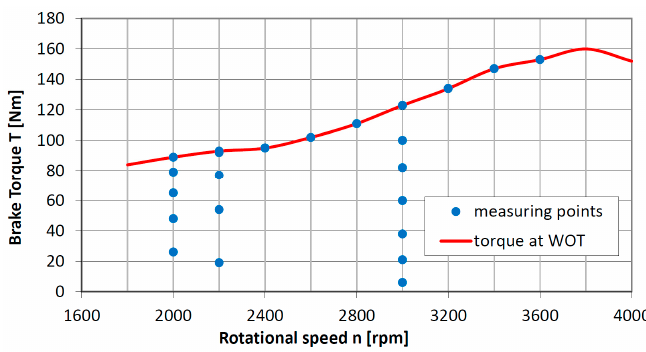
Figure 8. Measuring points for indicating measurements of the engine; Brake Torque (T).